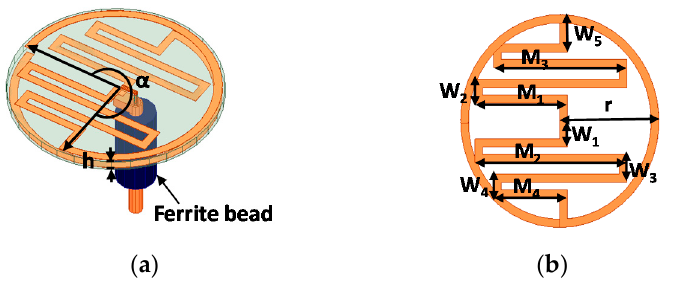
Figure 1. The proposed antenna design with the design parameters: ( a ) 3D and ( b ) top views. Rogers RT/duroid 5880™ with a thickness (h) of 0.72 mm ( ε r = 3 and tan δ = 0.0009) was used for